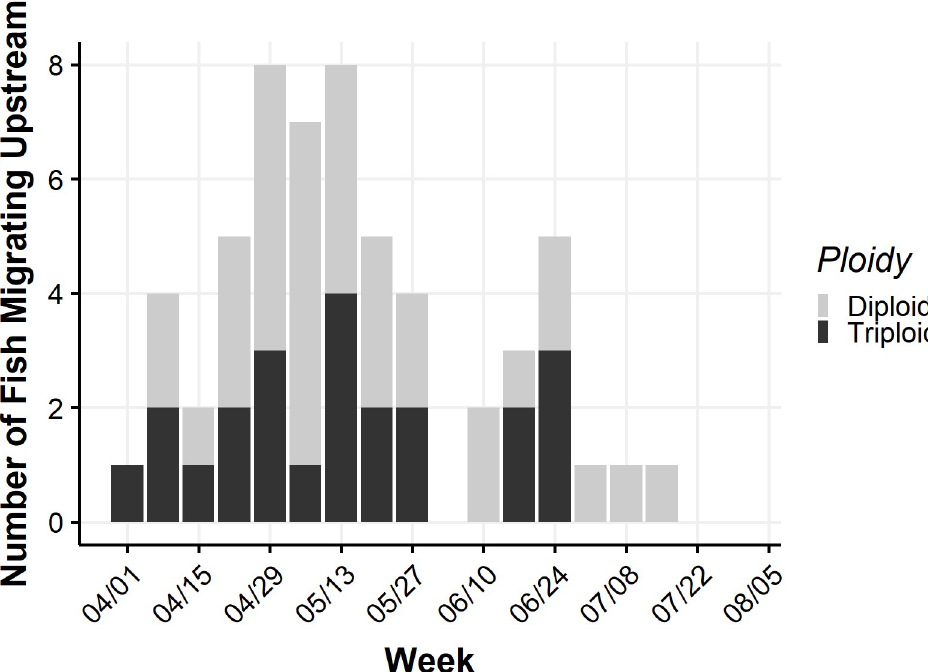
Fig 2. Timing of upstream migrations for 11 diploid and 9 triploid grass carp Ctenopharyngodon idella tracked via acoustic telemetry in the Osage River above Truman Reservoir, Missouri, 2019. Fish were included as engaging in upstream migration in any week in which � 12 h tracking period indicated migratory